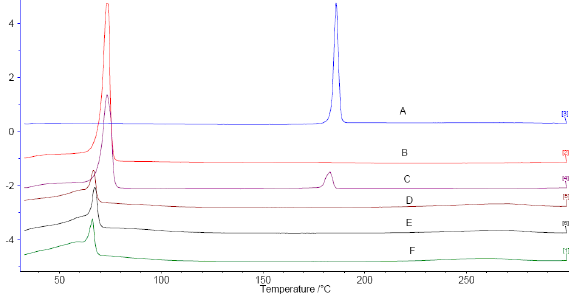
Figure 2. Differential Scanning Calorimetry (DSC) heating curves of podophyllotoxin-loaded nanostructured lipid carriers (POD-NLC) formulation 1 and POD-NLC formulation 2 from 30 to 300 °C at a heating rate of 10 °C/min. A : POD; B : Compritol 888 ATO; C : Physical mixture of POD and Compritol 888 ATO; D to F : Lyophilized NLC dispersions—namely, POD-NLC formulation 1 , POD-NLC formulation 2 , and Blank-NLC formulation 1 .